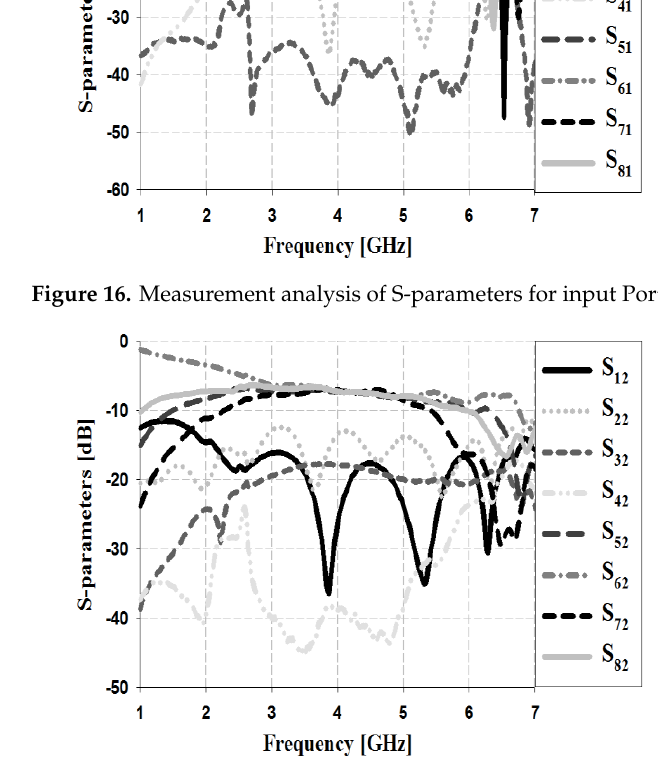
Figure 17. Measurement analysis of S-parameters for input Port 2.